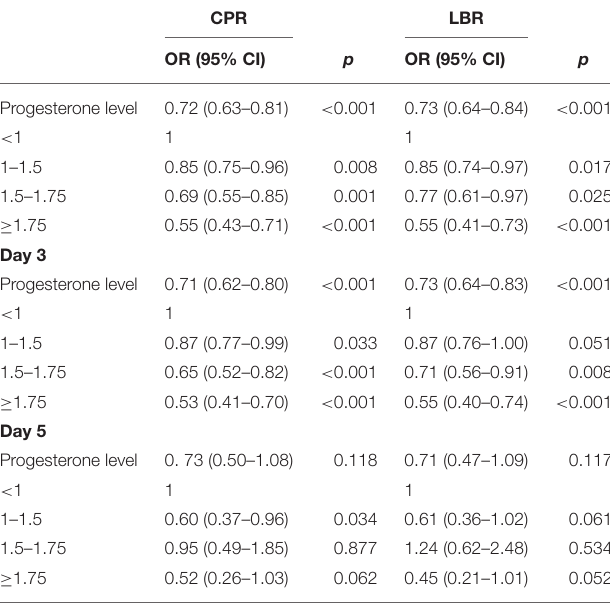
TABLE 2 | Influence of progesterone level on clinical pregnancy rate (CPR) and live birth rate